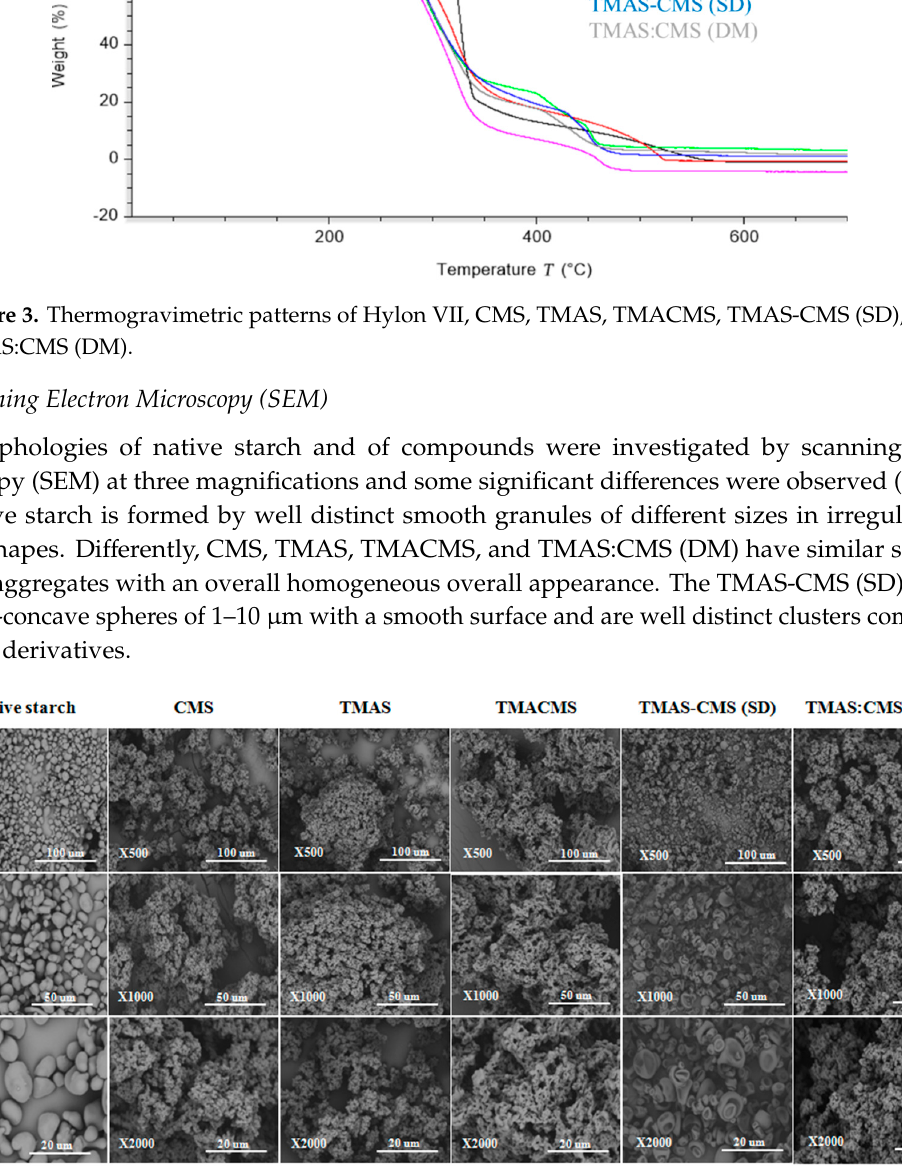
Figure 4. Scanning electron microscopy images of native starch, CMS, TMAS, TMACMS, TMAS-CMS (SD), and TMAS:CMS (DM) at magnifications ×500, ×1000, and ×2000.